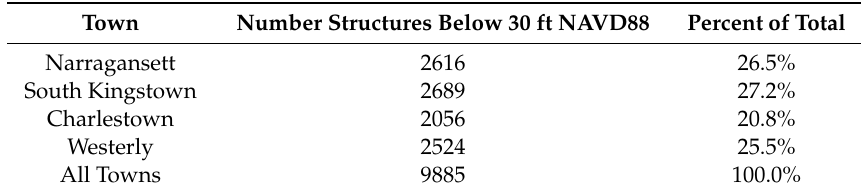
Table 3. Number of structures and percent of total that are located below 30 feet NAVD 88 for each town in the study